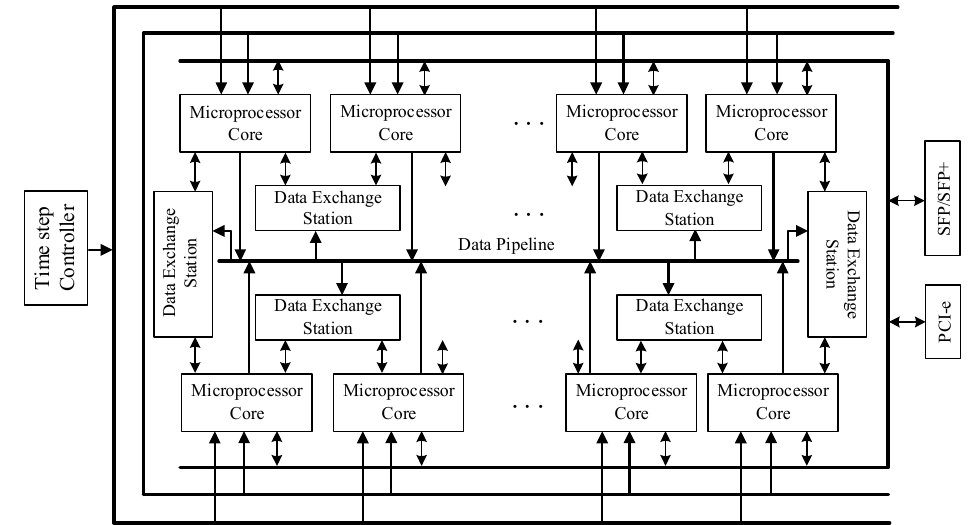
Figure 1. The overall structure of a field-programmable gate array (FPGA)-based real-time digital solver (FRTDS).